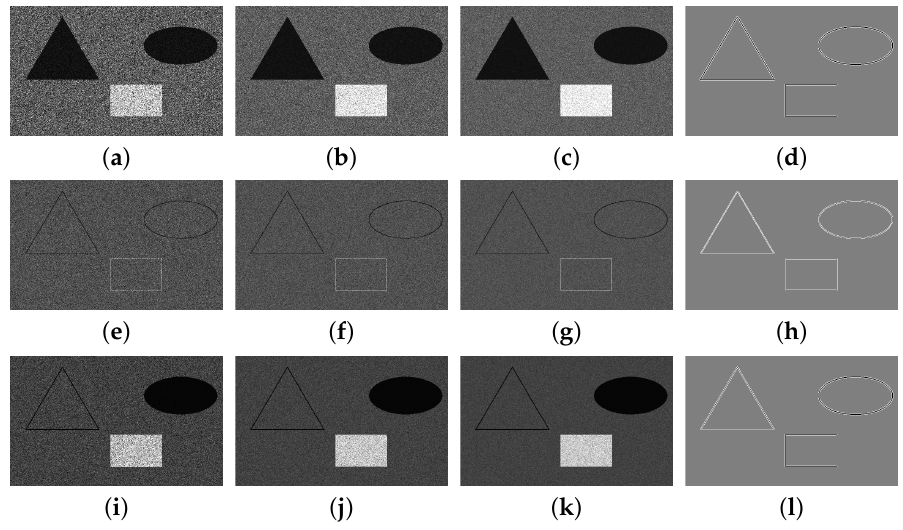
Figure 9. ( a ) One-look simulated SAR image (Step); ( b ) Three-look simulated SAR image (Step); ( c ) Six-look simulated SAR image (Step); ( d ) Ground truth (GT) map (Step); ( e ) One-look simulated SAR image (Roof); ( f ) Three-look simulated SAR image (Roof); ( g ) Six-look simulated SAR image (Roof); ( h ) GT map (Roof); ( i ) One-look simulated SAR image (Step and Roof); ( j ) Three-look simulated SAR image (Step and Roof); ( k ) Six-look simulated SAR image (Step and Roof); ( l ) GT map (Step and Roof).